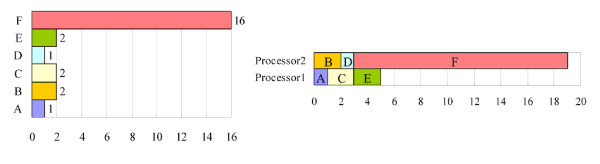
An example of the second potential problem of parallel signature discovery. The tasks can be completed in 24 units by a single-processor computer. The overall processing time is 19 units for a two-processor computer, which exceeds the optimal processing time, 12 units.